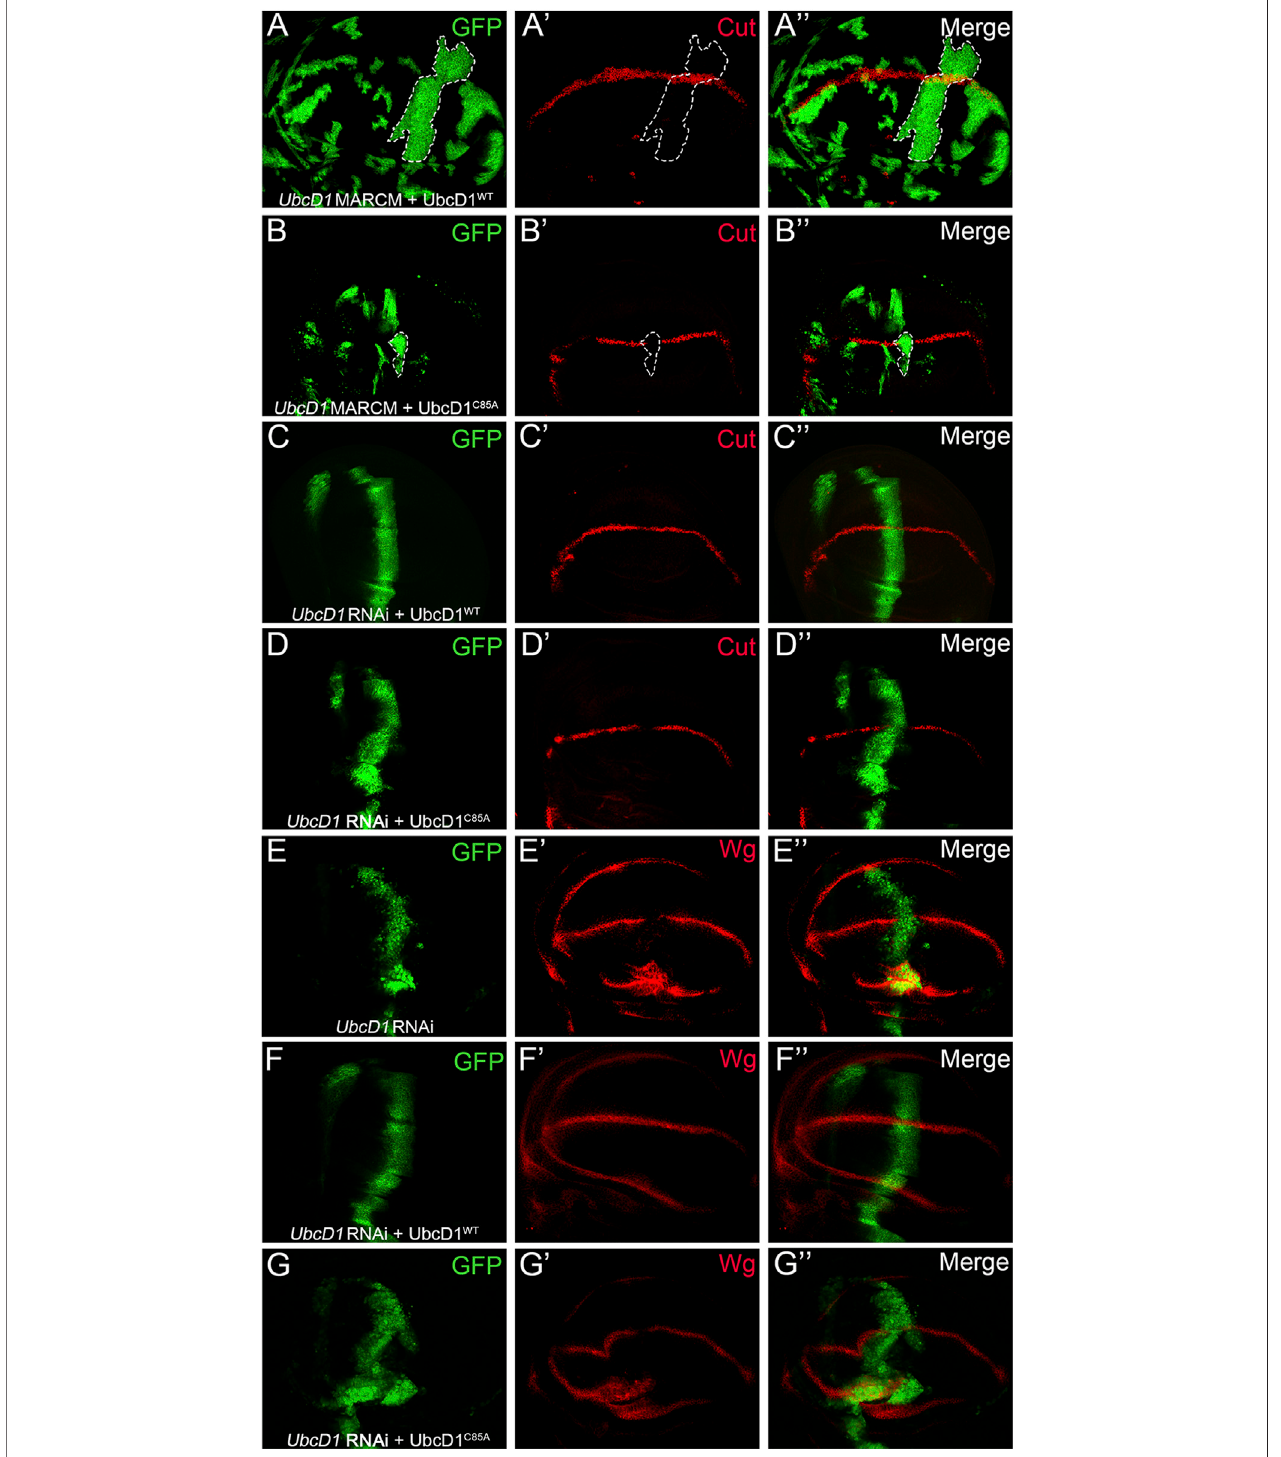
FIGURE7| UbcD1functionsasanE2enzyme. (A – B) In UbcD1 mer1 mutantcells,UbcD1 WT (A) butnotUbcD1 C85A (B) issuf fi cienttorestoretheexpressionofCut. MARCMclonesaremarkedbyGFP.Representativeclonesarecircledbydashedlines. (C – D) UbcD1 WT (C) butnotUbcD1 C85A (D) isabletorescuethereductionofCut expression caused by UbcD1 RNAi. (E – G) RNAi knock-down of UbcD1 leads to inhibition of Wg expression (E) , which is rescued by UbcD1 WT (F) but not UbcD1 C85A (G) . Note that Wg are accumulated in cells at the edge of wing pouch upon UbcD1 RNAi (E, G) . The RNAi expressing cells are marked by GFP.